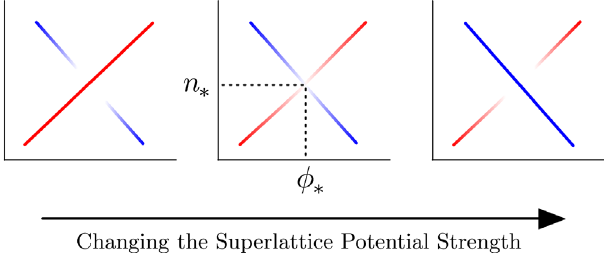
FIG. 1. Red and blue lines represent gapped trajectories labeled by ð C; s Þ and ð C 0 ; s 0 Þ , respectively, which intersect at ð n For a generic value of the tuning parameter m (superlattice potential strength), one type of gap will “ win ” over the other at the crossing. At the critical value m ¼ m c , the gap closes and their relative strength is exchanged; this is the manifestation of a Chern-number changing transition.